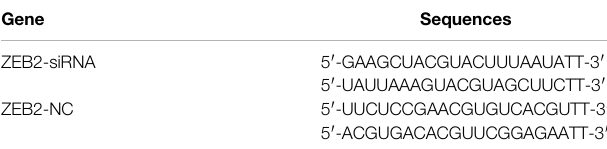
TABLE 1 | Sequences used in transfection.